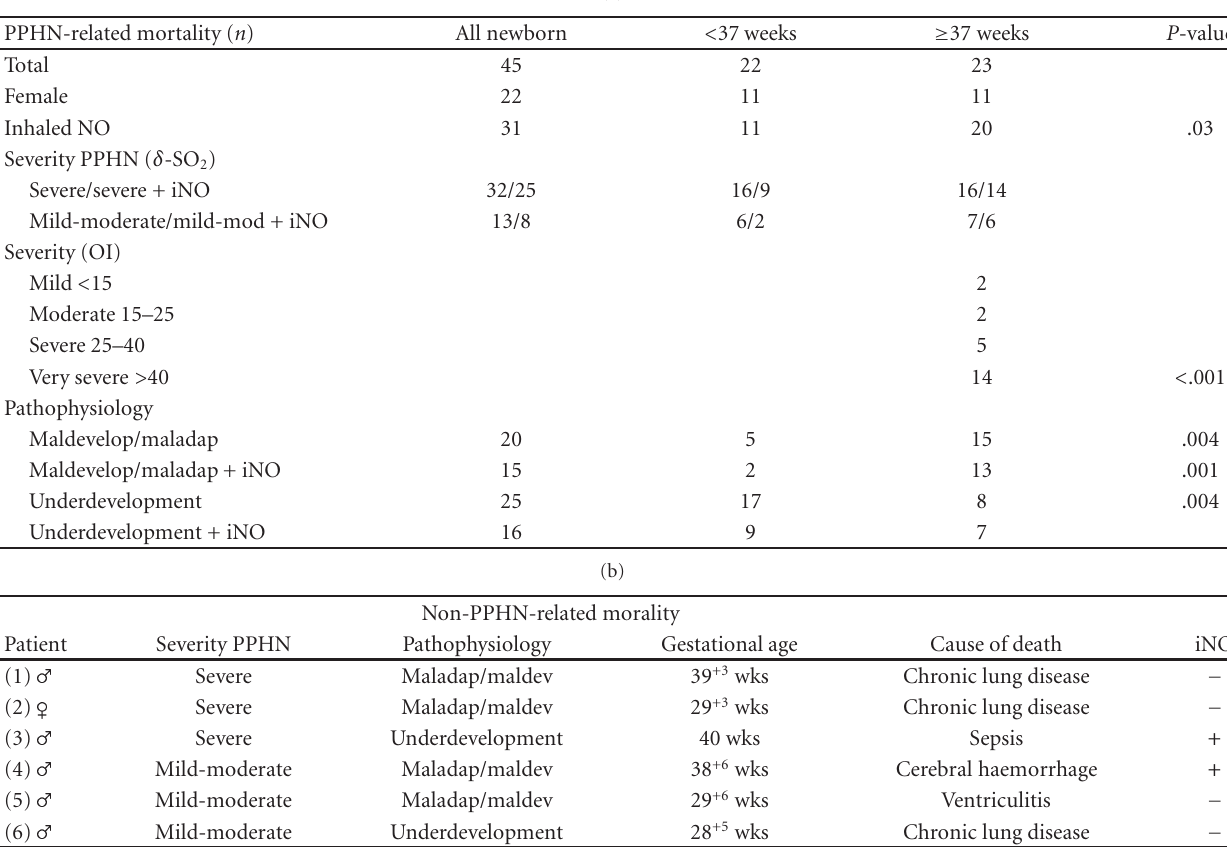
Table 2: Patient characteristics of PPHN-related and non-PPHN-related